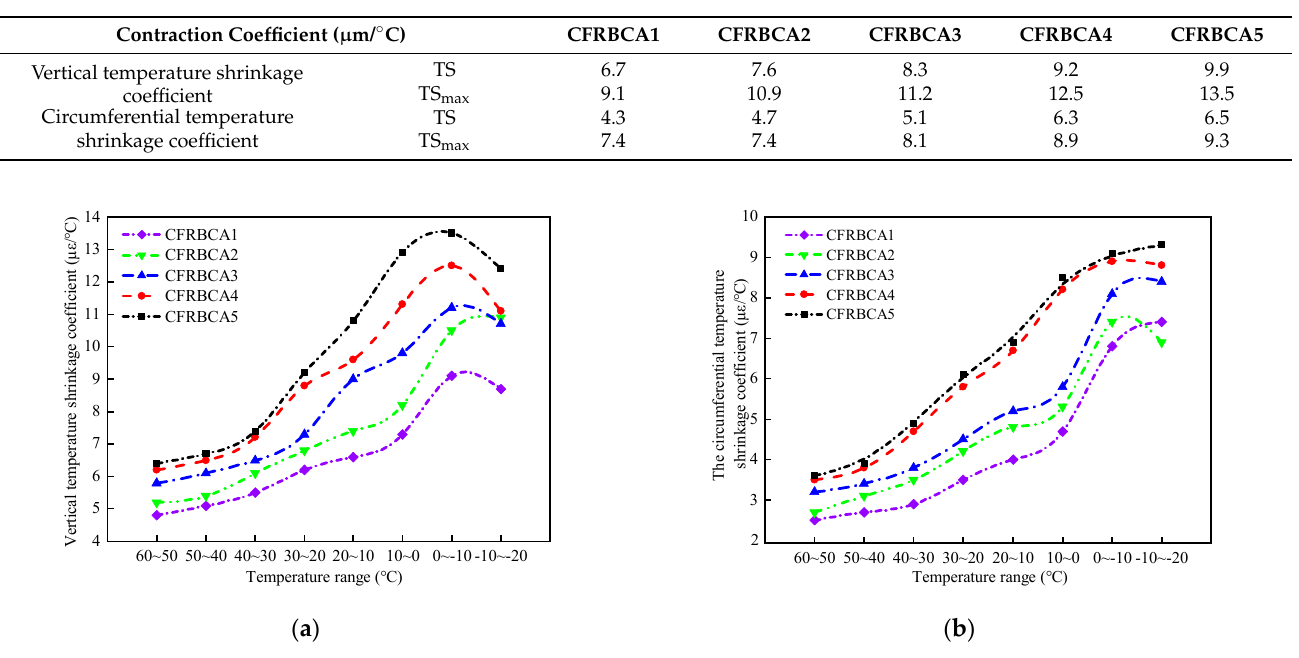
Figure 3. Relationship between temperature shrinkage coefficient and temperature range: ( a ) Vertical temperature shrinkage, ( b ) Circumferential temperature shrinkage.